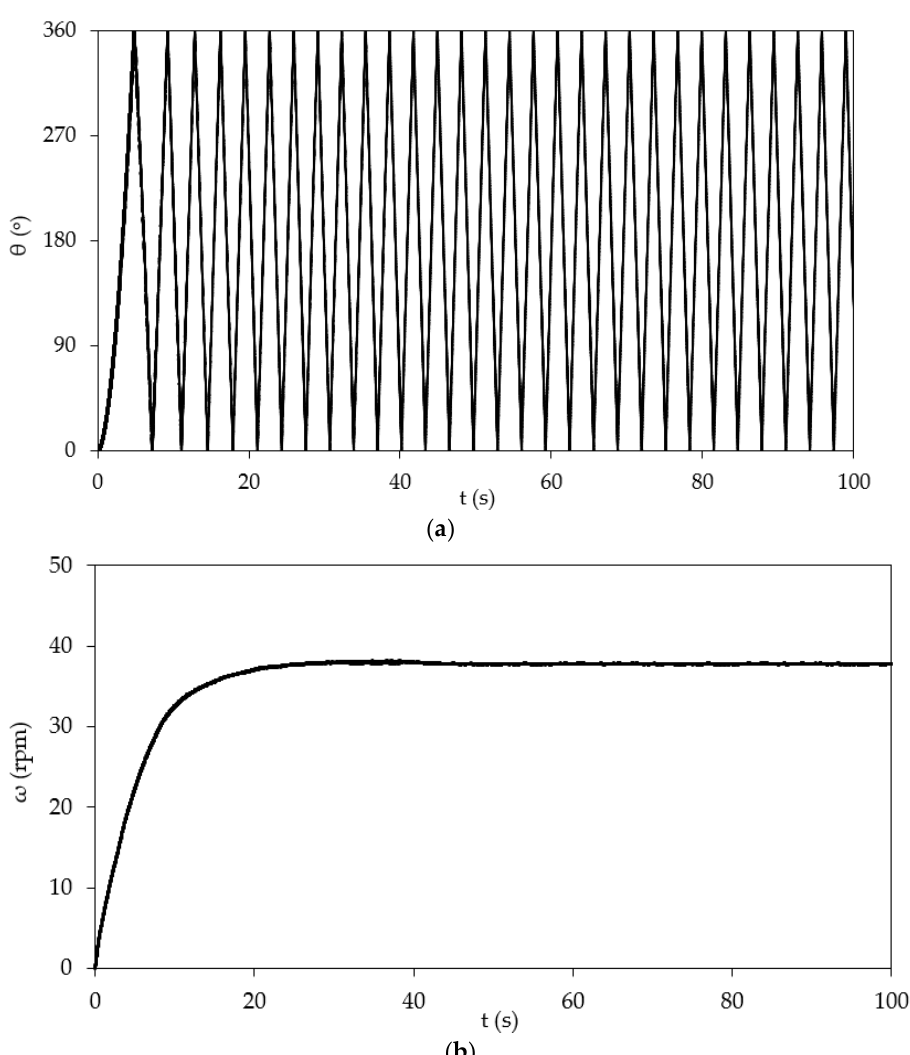
Figure 6. Rotational characteristics of the VAWT without stator.